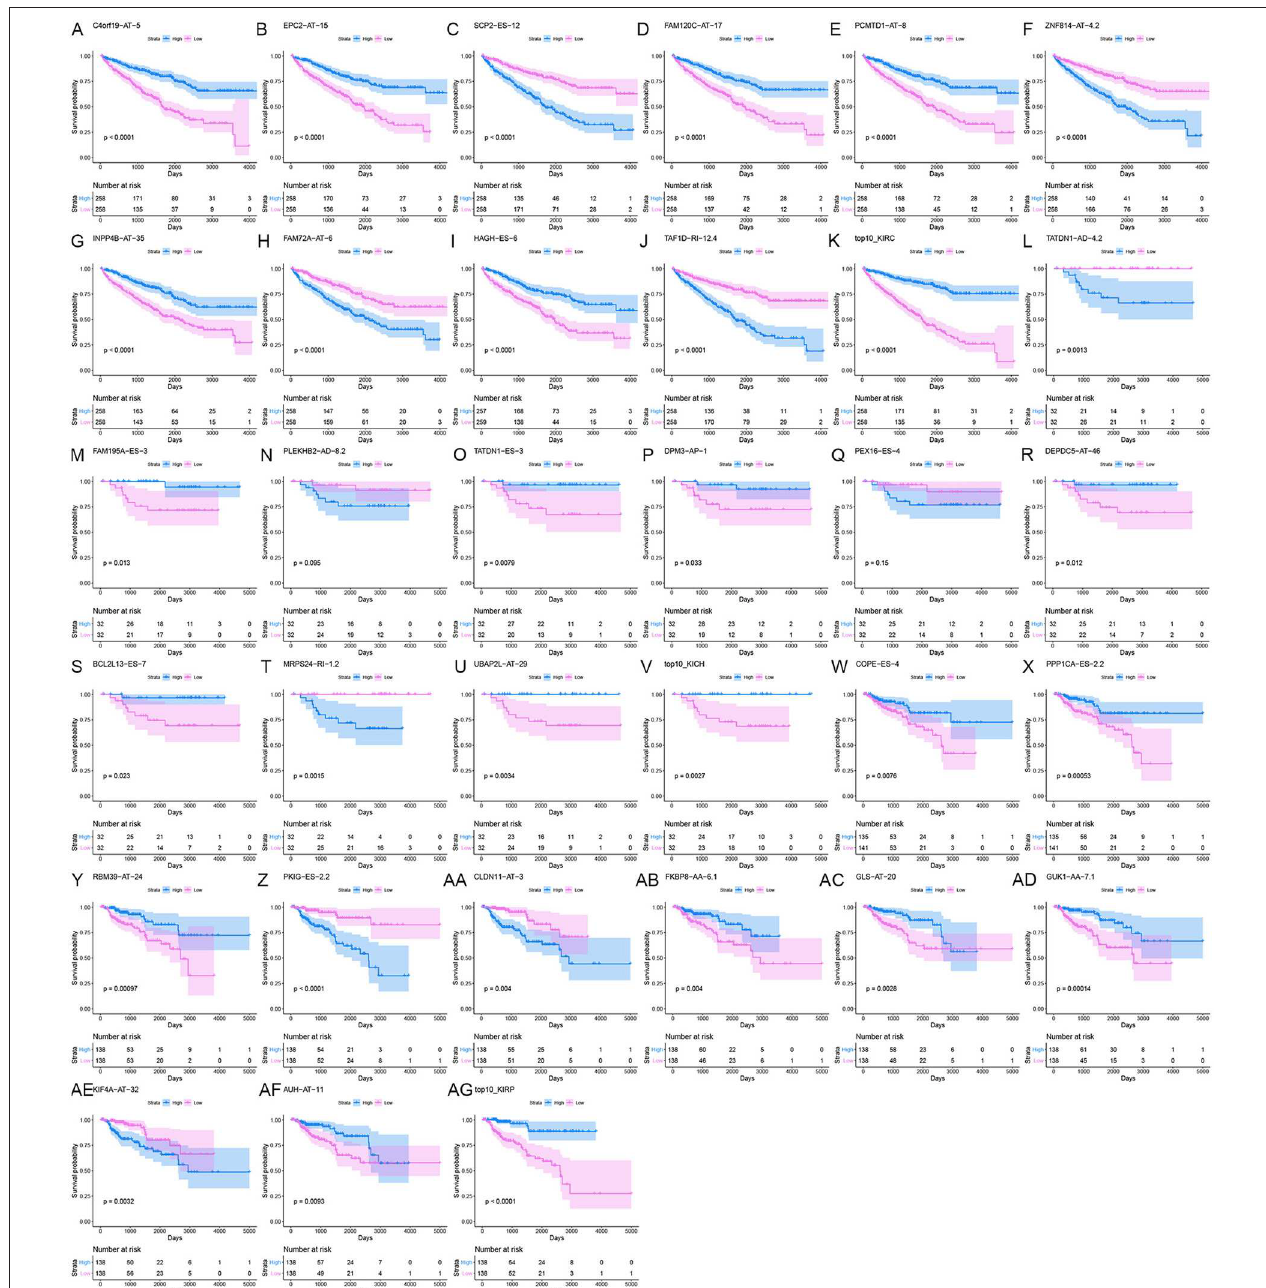
FIGURE 4 | The survival curve for different prognostic factors. In the upper graph, the blue curve represented the group with high PSI values; the pink curve represented the group with low PSI values. The table below showed the number of people at risk that change over time. (A) Survival curve based on the PSI value of C4orf19_AT_5 in KIRC. (B) Survival curve based on the PSI value of EPC2_AT_15 in KIRC. (C) Survival curve based on the PSI value of SCP2_ES_12 in KIRC. (D) Survival curve based on the PSI value of FAM120C_AT_17 in KIRC. (E) Survival curve based on the PSI value of PCMTD1_AT_8 in KIRC. (F) Survival curve based on the PSI value of ZNF814_AT_4.2 in KIRC. (G) Survival curve based on the PSI value of INPP4B_AT_35 in KIRC. (H) Survival curve based on the PSI value of FAM72A_AT_6 in KIRC. (I) Survival curve based on the PSI value of HAGH_ES_6 in KIRC. (J) Survival curve based on the PSI value of TAF1D_RI_12.4 in KIRC. (K) Survival curve based on the weighted PSI value of KIRC. (L) Survival curve based on the PSI value of TATDN1_AD_4.2 in KICH. (M) Survival curve based on the PSI value of FAM195A_ES_3 in KICH. (N) Survival curve based on the PSI value of PLEKHB2_AD_8.2 in KICH. (O) Survival curve based on the PSI value of TATDN1_ES_3 in KICH. (P) Survival curve based on the PSI value of DPM3_AP_1 in KICH. (Q) Survival curve based on the PSI value of PEX16_ES_4 in KICH. (R) Survival curve based on the PSI value of DEPDC5_AT_46 in KICH. (S) Survival curve based on the PSI value of BCL2L13_ES_7 in KICH. (T) Survival curve based on the PSI value of MRPS24_RI_1.2 in KICH. (U) Survival curve based on the PSI value of UBAP2L_AT_29 in KICH. (V) Survival curve based on the weighted PSI value of